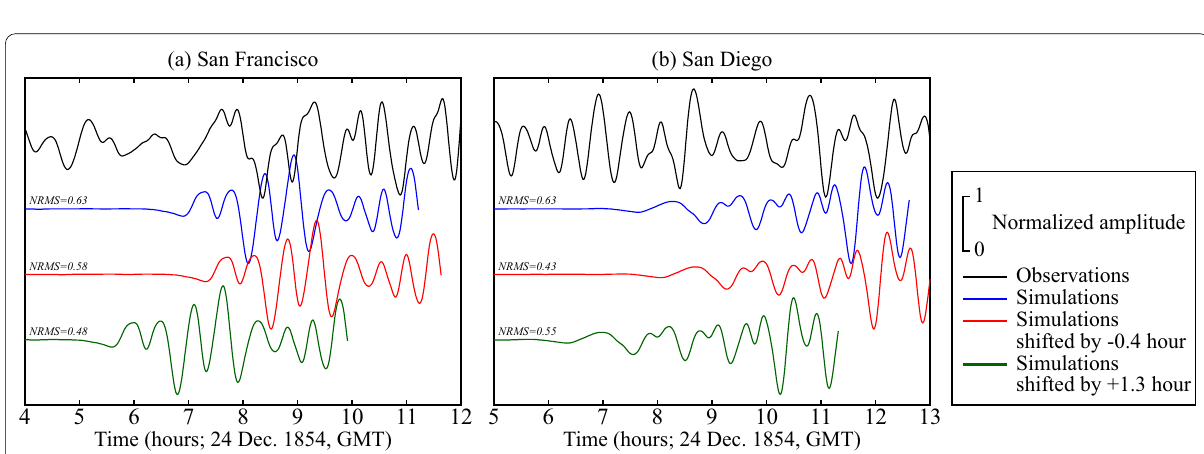
Fig. 7 Comparison of observed and simulated waveforms of the 1854 CE Ansei–Nankai tsunami recorded at the a San Francisco and b San Diego tide gauge stations. Black, blue, red, and green curves show the observations, simulations, and simulations shifted by